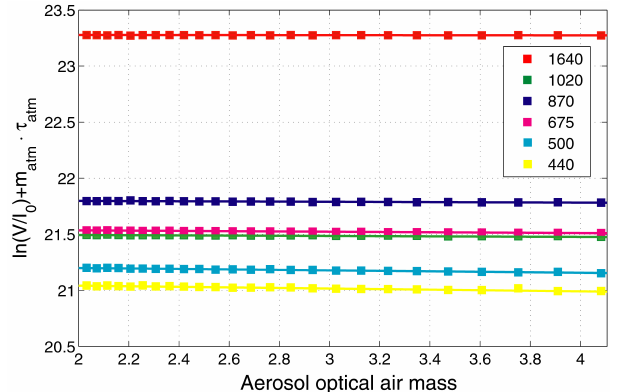
Fig. 1. Lunar Langley-plot analysis performed on the moonset of 9 February for